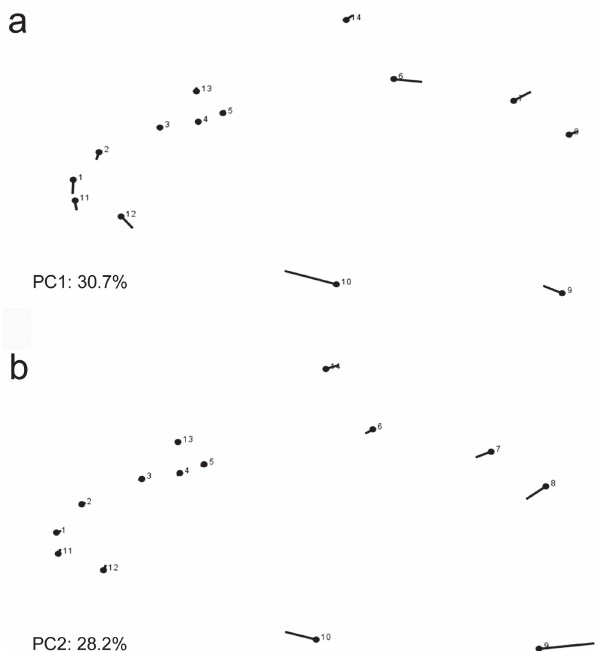
Fig. 21. Results of geometric morphometric analysis of Sternarchella orthos from river basins of northern South America. a. PC1 corresponds to variation in position of mouth, anus, and posterior head margin. b. PC2 corresponds to variation in opercle width, and position of anus and anal- fin